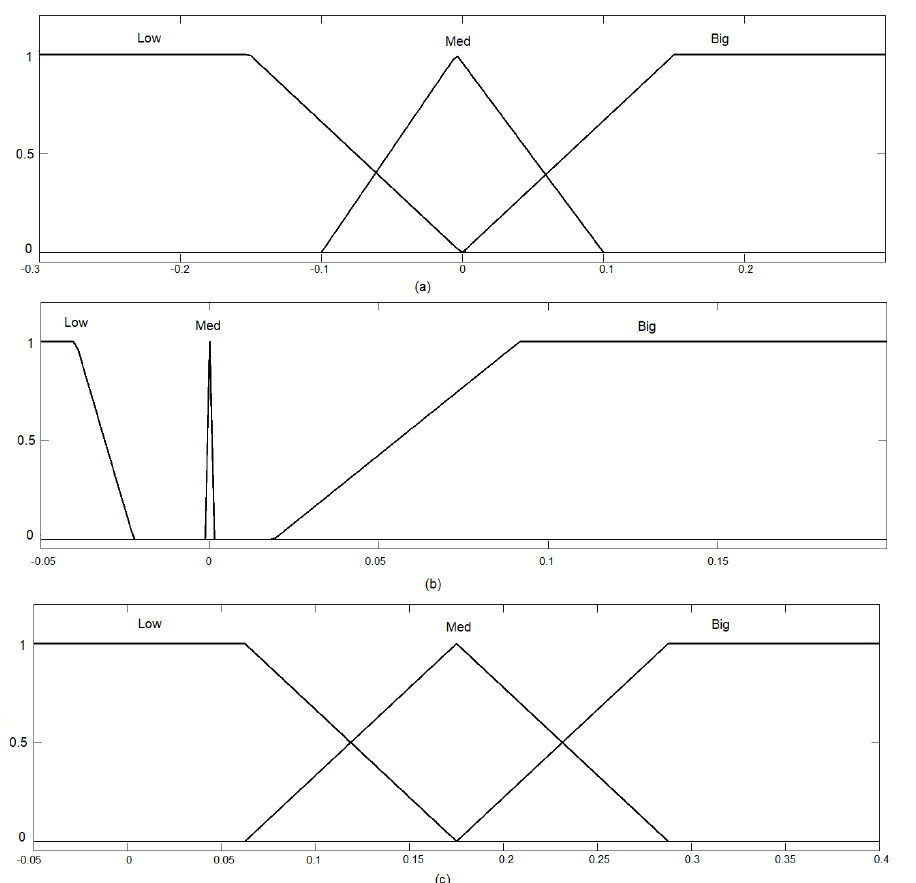
Figure 7. Output defuzzification: ( a ) Delta-P; ( b ) Delta-I; and ( c ) Delta-D.